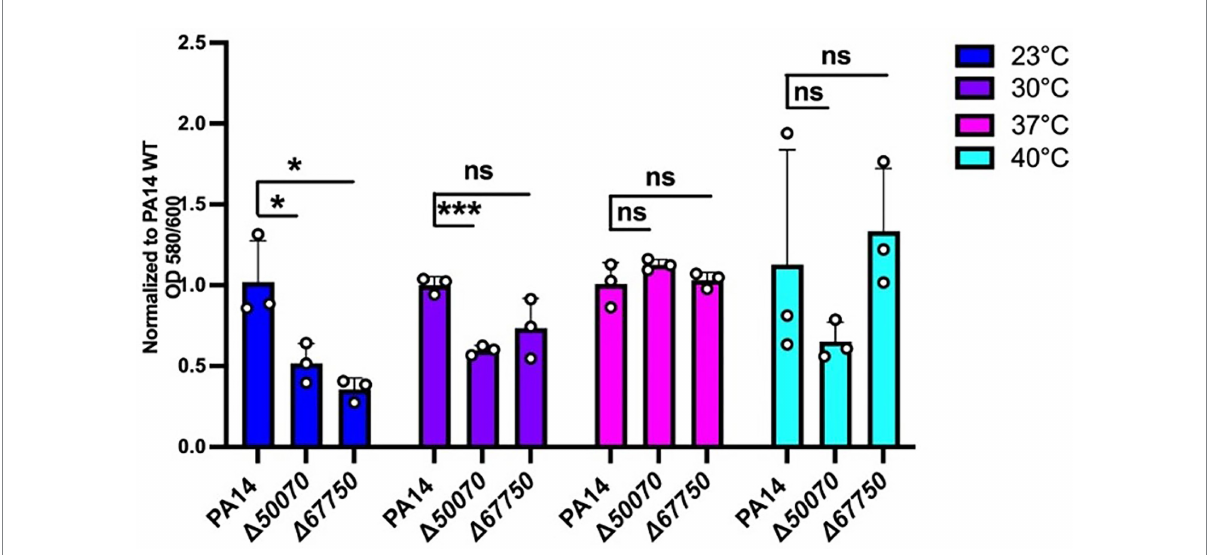
FIGURE 6 Growth requirements for biofilm formation at environmental versus host temperatures. The biofilm biomass (ratio of OD580/OD600), at each temperature for the two mutants was normalized relative to WT PA14 at the different temperatures. The biomass of the biofilm was defective at 23 ° C for both mutants and at 30 ° C for PA14_50070 when compared to PA14. Bars represent the mean of three biological replicates performed on different days. The mean of each biological replicate was based on three technical replicates. Error bars represent the standard error of mean of the biological replicates. Unpaired t-test (two-tailed) was used to measure statistical significance between the wildtype and each mutant. ns: not significant, and * p ≤0.05, and *** p